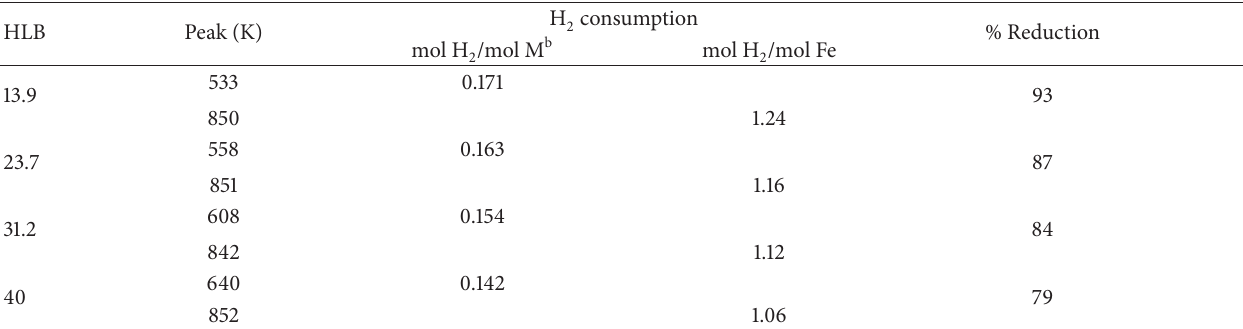
consumption for catalysts in H 2